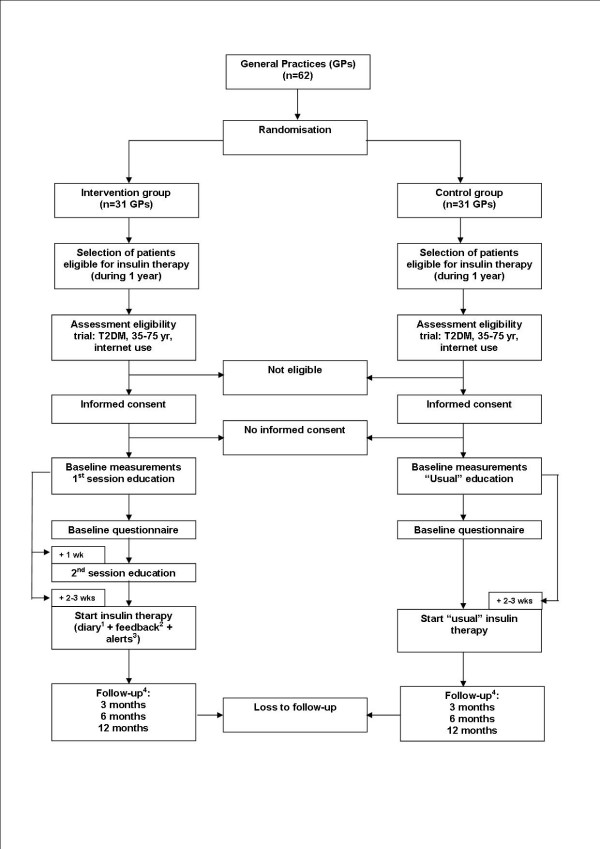
Flowchart of the study.1 The online diary is used for monitoring blood glucose measurements.2 Feedback consistsof 1. a graphic presentation of the input 2. a dose advice for thenext 2 days or coming period 3. compliments/advice.3 Alerts are generated when there is a medical urgency: hypoglycaemia (< 2.5 mmol/l) or hyperglycaemia (FBG > 20 mmol/l). When the patient gets an alert (feedback and advice), this is also sent to the GP.4 Follow up consists of questionnaires and measurements of physical and clinical characteristics (see text: 'outcome assessment').